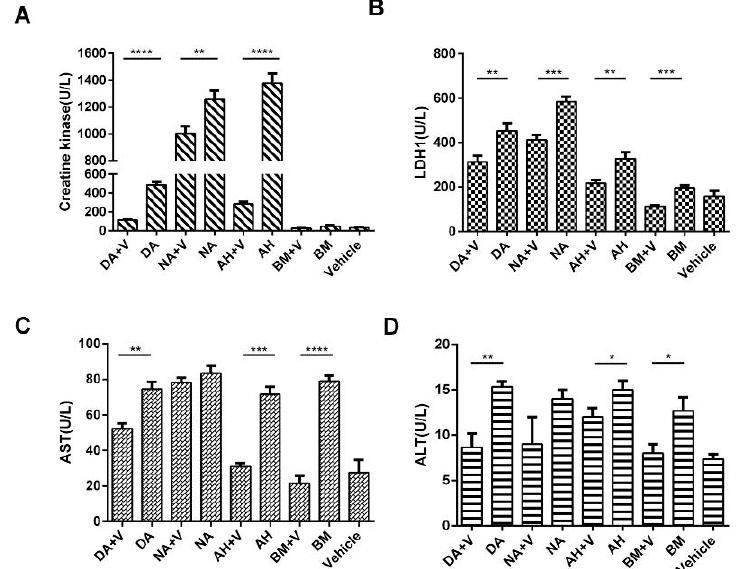
Figure 6. Alterations in serum CK, LDH1, AST, and ALT levels following snake envenomation. ( A ) Serum CK level in DA, NA and AH envenomed mice significantly increased, while it dramatically reduced in the presence of varespladib; ( B ) Serum LDH1 in all envenomed group showed overtly higher activity than varespladib group; ( C , D ) AST and ALT levels exhibited remarkable increase in DA, AH and BM envenomed group, but the effect was significantly relieved with varespladib. The systemic damage following envenomation was dramatically reduced in the presence of varespladib.